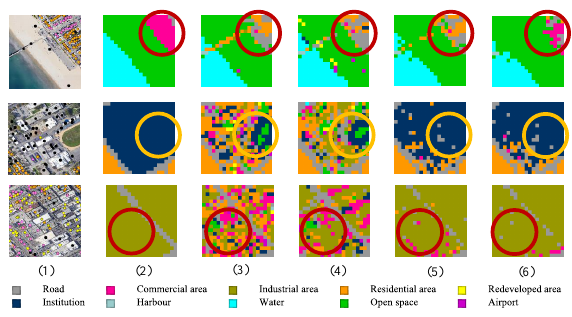
Figure 5. UFZ classification results using CSU-RESISC10 dataset. (1) Images and POI. (2) Ground truth. (3) Xception. (4) SPP-Net with MKL (5) SIF-Net without CAM. (6) SIF-Net. Small circles in (1) are POI data. Orange circles represent houses and apartments. Pink represent hotel, retail, and commercial. Yellow, blue, and black represent industrial, institution and unclassified.